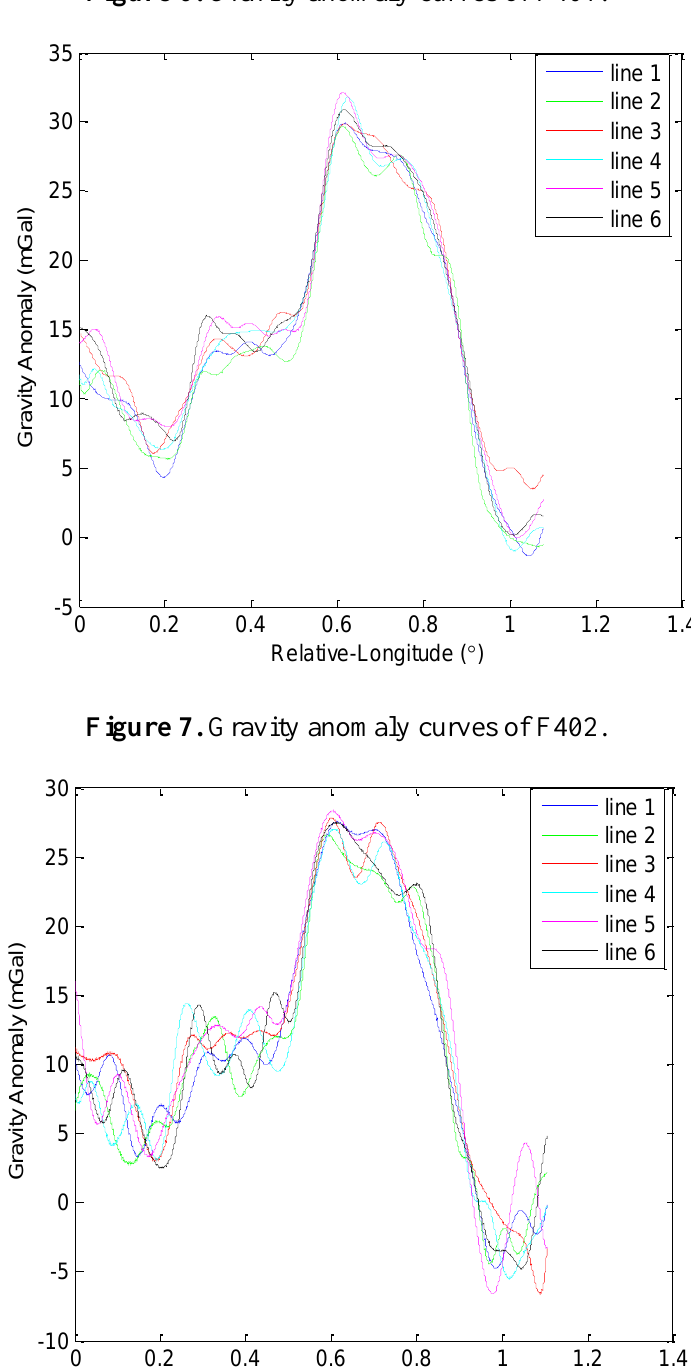
Figure 6. Gravity anomaly curves of F401.